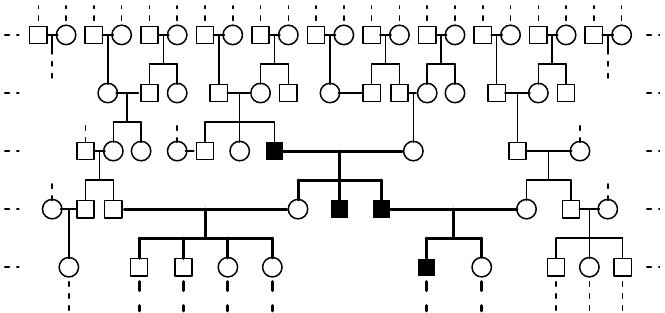
Figure 1. Generation-by-generation evolution of a simulated Y-linked pedigree (bold line) within an overall population. (cid:13) Female, (cid:3) male without the target allele, and (cid:4) male with the target